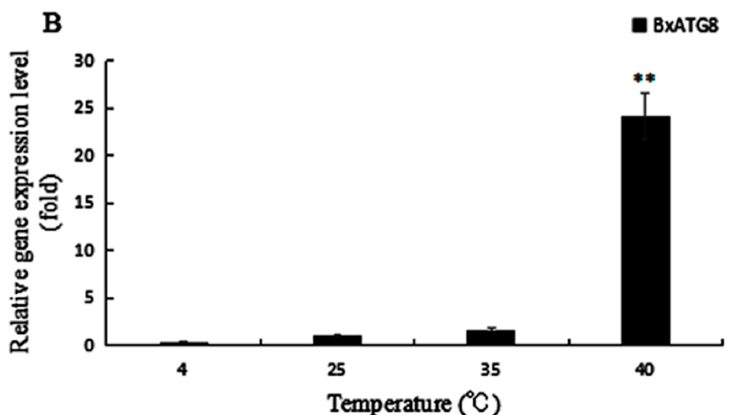
Figure 4. Quantitative reverse transcription PCR (qRT-PCR) analysis of: BxATG1 ( A ); and BxATG8 ( B ), in PWN after treated at different temperatures. The expression level of 25 °C was set as 100%. Data